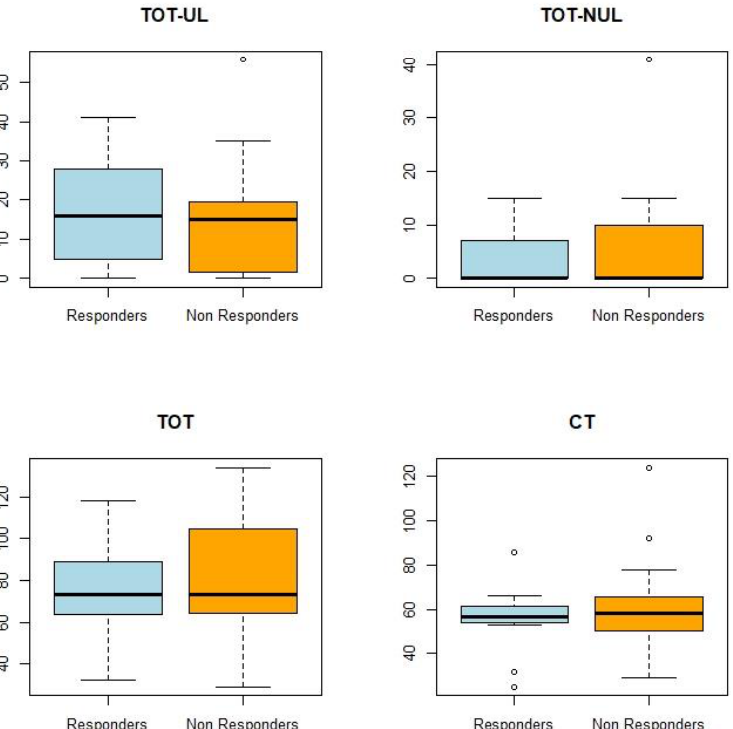
Figure 1. Dose of rehabilitation of the Responders and Non-Responders for FMA-UE. Boxplot of outcomes by Responders and Non-Responders; TOT-UL: total amount of rehabilitation specific for the UL (hours of UL technologies and OT); TOT-NUL: total hours of rehabilitation non-specific for the UL (hours of LL technologies); TOT: total amount of rehabilitation (hours); CT: conventional therapy. Table 6. Relationship between the FMA-UE Responders and clinical and rehabilitation features. Regression Model β ±